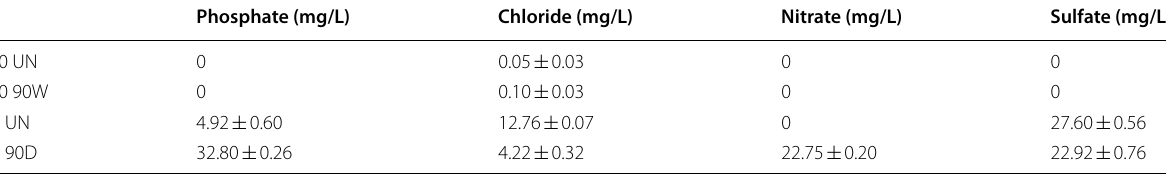
The filtrate was obtained from the 2nd wash (25 mL) of 1.5 g biochar. The values shown are averages of 3 replicates ( n Additional file 1: Fig.